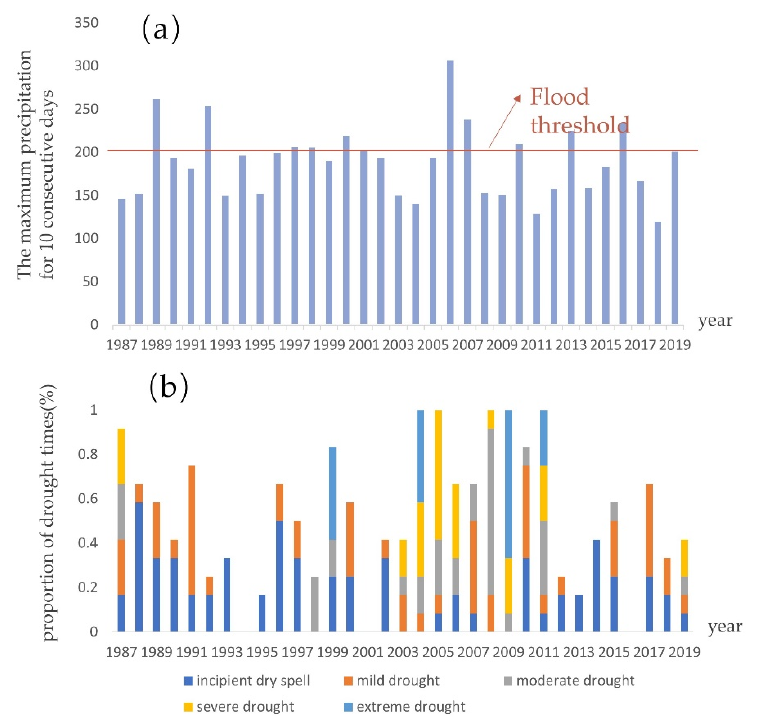
Figure 11. ( a ) Actual SL IST-cube diagram containing two layers representing two years. The aver- age number of pixels per year is 14 647, conforming to the criterion for the SL IST-cube class. ( b ) Spatial distribution map of occurrence number for the SL IST-cube.